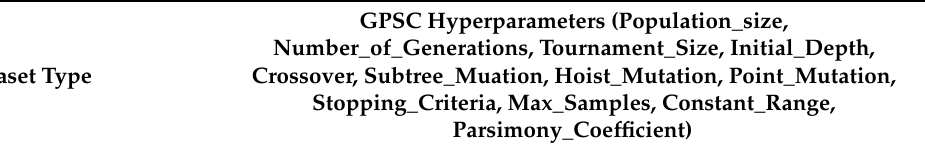
Table 5. The list of randomly chosen hyperparameters used to obtain best symbolic expressions for each dataset variation with high classification